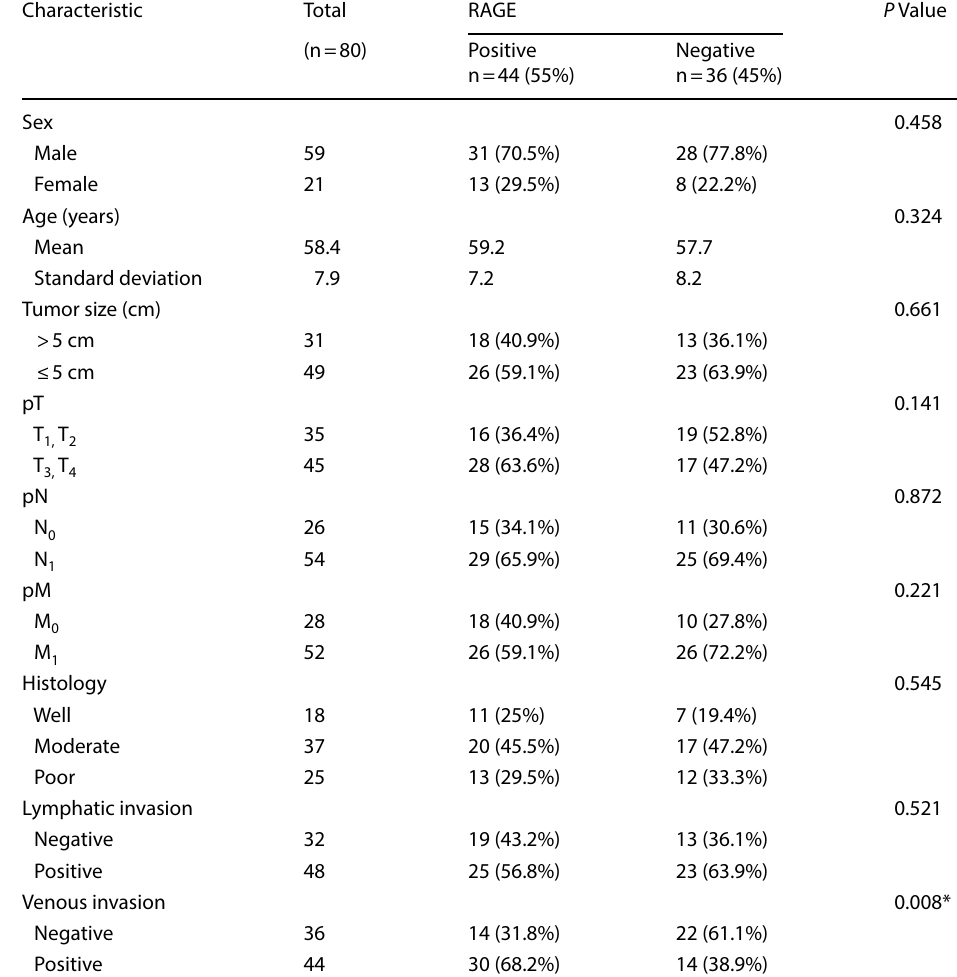
Table 4 Correlation between RAGE expression and clinicopatholological characteristics of the patients